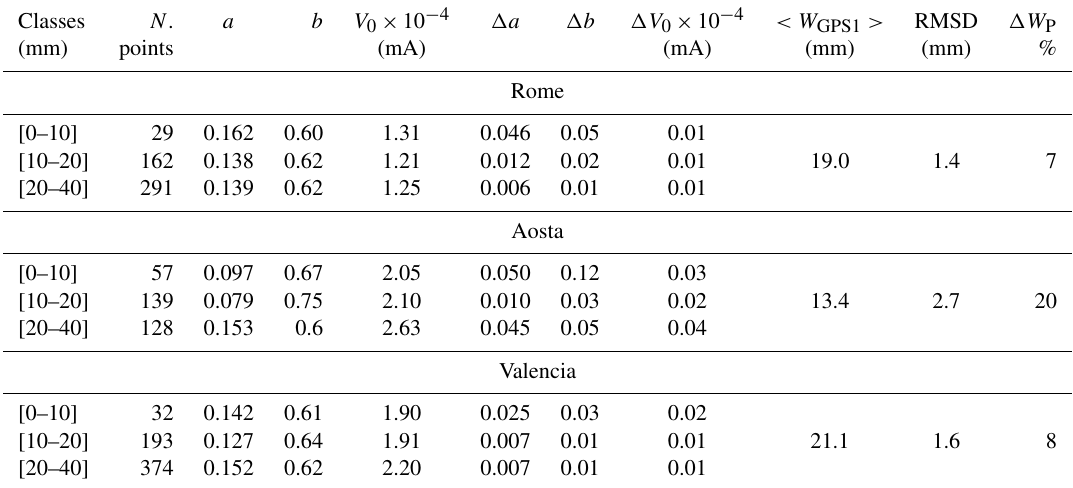
Table 2. For each class and each site are listed the number of data points, the optimal values of calibration constants, their estimated errors, the mean value of W and the estimated uncertainty of W P . Classes N